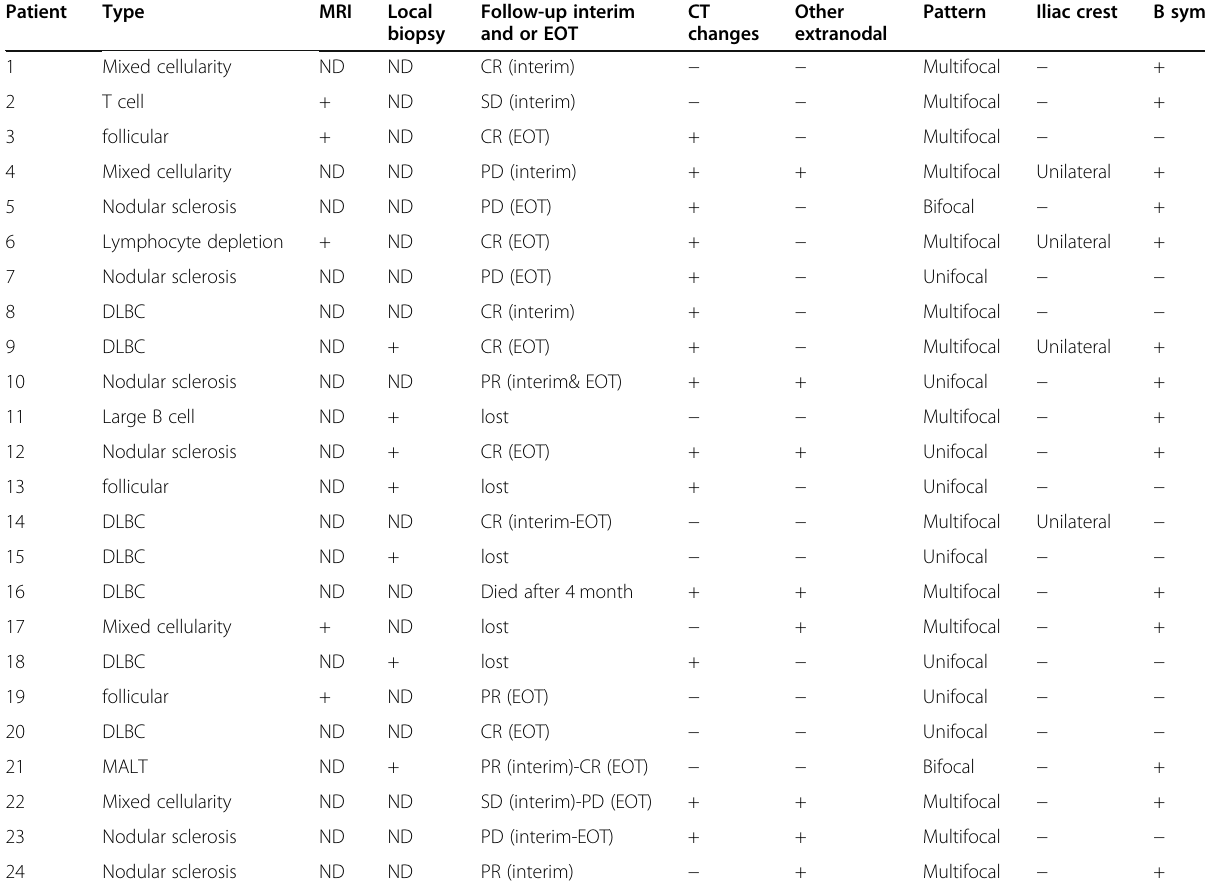
Table 6 Cases with true positive PET/CT and negative iliac crest BMB results